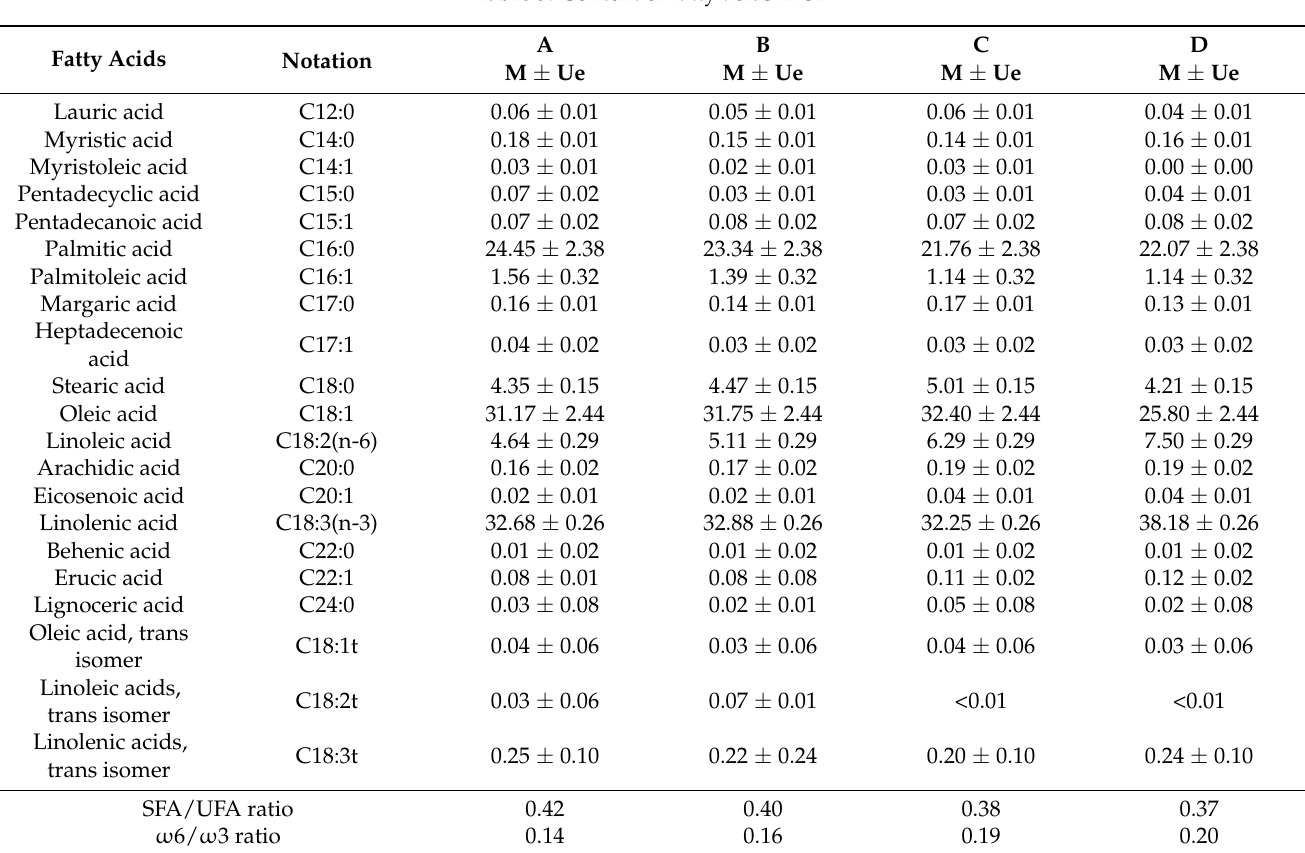
Table 3. Content of fatty acids in SP.